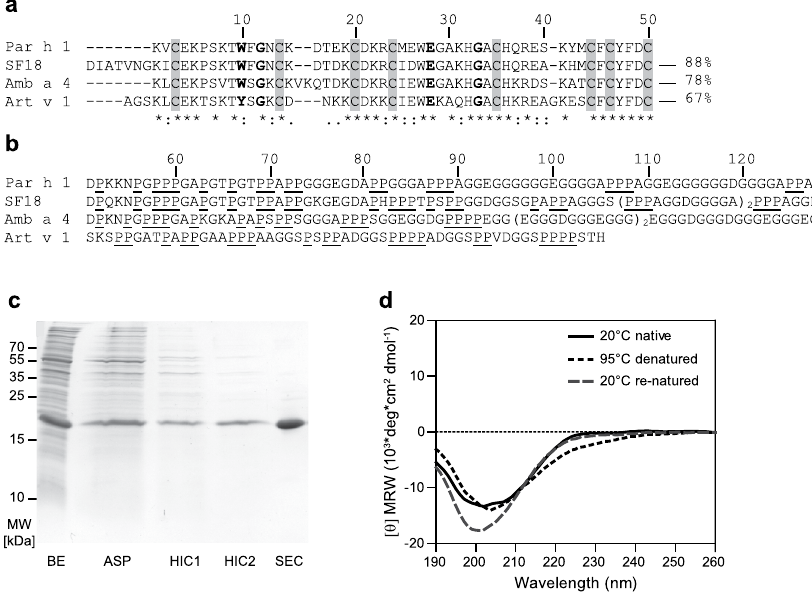
Figure 1. Sequence analysis, purification and secondary structure elements of recombinant Par h 1. ( a ) Sequence alignment of defensin-like domains obtained with the multiple sequence alignment program Clustal Omega ( b ), comparison of proline-rich regions. Art v 1 from Artemisia vulgaris (Q84ZX5), Amb a 4 from Ambrosia artemisiifolia (D4IHC0) and SF18 from Helianthus annuus (P22357) were included. Conserved cysteine residues boxed in grey, conserved residues of defensin-like proteins in bold, proline clusters underlined. The symbols shown in the alignment correspond with identical amino acids ( * ), conserved substitutions (:), and semi-conserved substitutions (.). ( c ) Purification process of recombinant Par h 1: BE, bacterial extract; ASP, ammonium sulfate precipitation; HIC1 and HIC2, hydrophobic interaction chromatography and SEC, size exclusion chromatography. ( d ) Circular dichroism spectra of purified Par h 1. The unprocessed gel is shown in the Related Manuscript